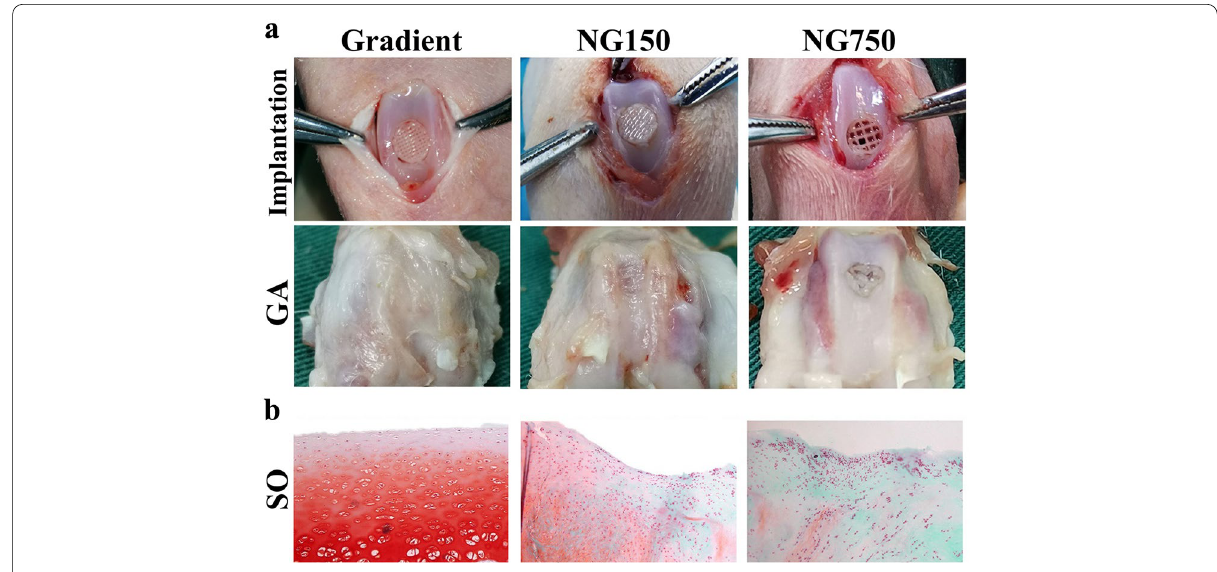
Fig. 6 In vivo efficacy of PCL